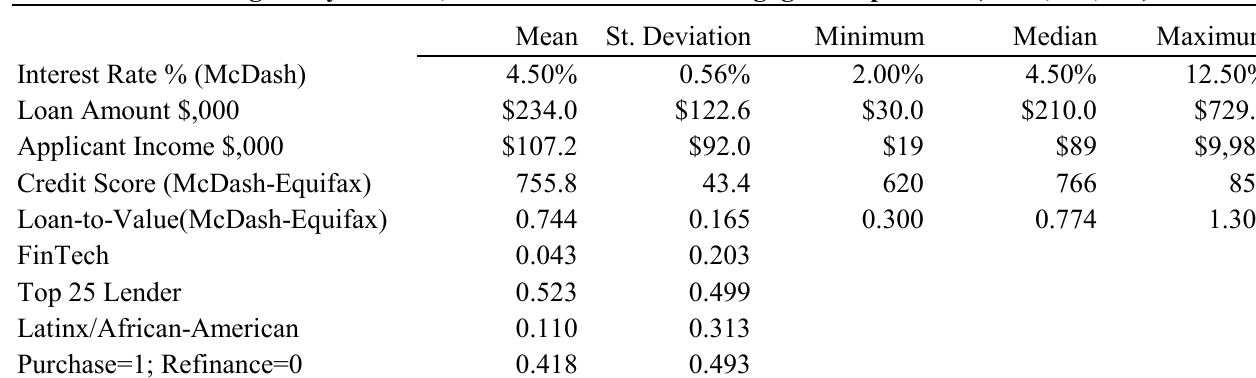
Table 1: Summary Statistics